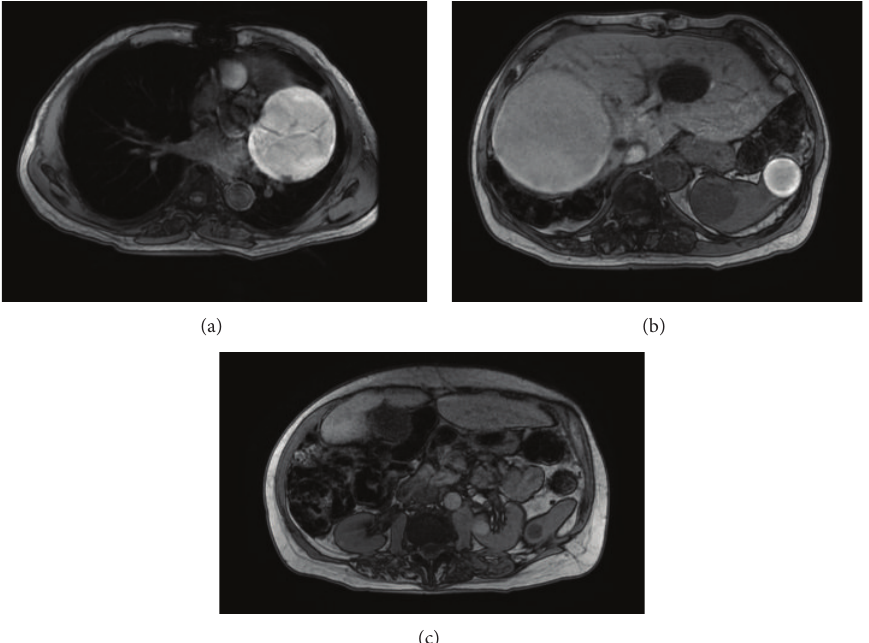
Figure 1: MRI of the abdomen with/without contrast (04-01-2011). (a) A heterogeneous mass is again seen adjacent to the left heart border, measuring approximately 8.5 × 8.0 cm which is partially visualized. Again, a vascular lesion is not excluded. (b) Multiple hepatic cysts are again demonstrated. A large mixed signal mass is again identified in the right lobe of the liver, which in the current study measures 13.0 × 11.7cm. This measured 19 × 15 cm in the prior study and appears smaller in the current study. Multiple cystic lesions are again noted in the spleen. There is a mass within the spleen anteriorly which again demonstrates a peripheral rim of hypointensity, measuring approximately 3.5 × 3.6 cm. Multiple splenic cysts are noted. (c) Multiple renal cysts are present. There is a new well-circumscribed lesion in the mid pole of the left kidney measuring 1.7 × 1.6cm which is T1 hyperintense and vaguely T2 hypointense. The subtraction image demonstrated no significant enhancement in this region. This likely represents a hyperdense cyst. There are several T1 hyperintense lesions within the kidneys bilaterally, which are too small to characterize. There are several nonenhancing T2 hyperintensities identified that appear to be within the pancreas; however, these are difficult to evaluate due to overlapping soft tissue structures in this